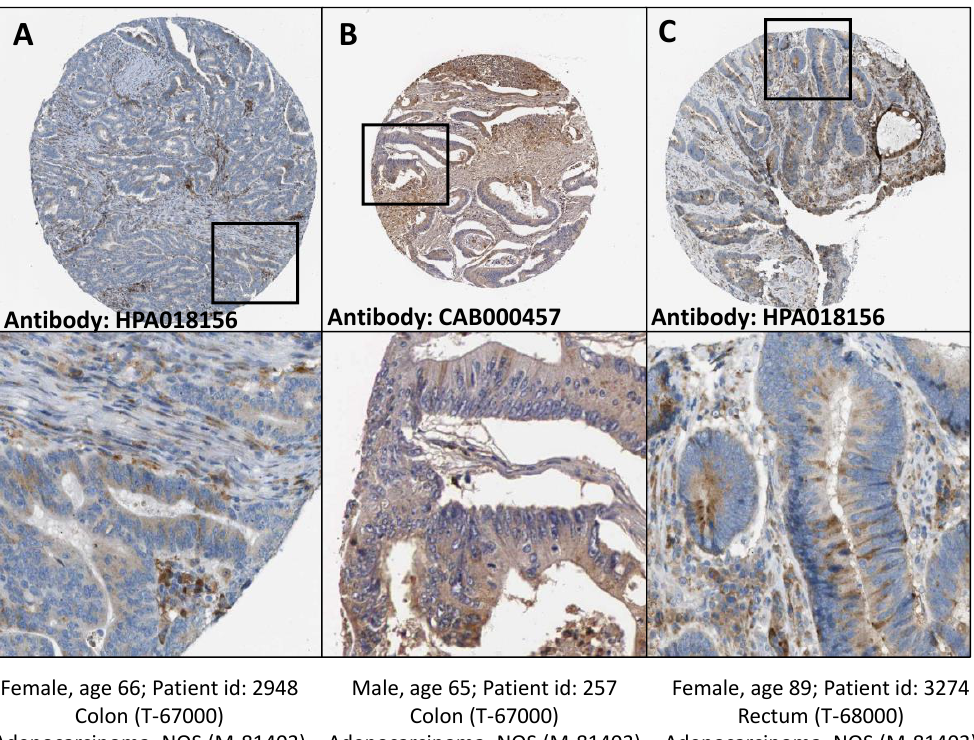
Figure 6. Cathepsin B detection in tissue samples from human colon and rectum adenocarcinoma. Human colon ( A , B ) and rectum ( C ) adenocarcinoma tissue samples, stained with anti cathepsin B antibodies HPA018156 ( A , C ) or CAB000457 ( B ). Cathepsin B location: cytoplasmic/membranous. Staining quality medium, staining intensity moderate. Image credits: Human Protein Atlas, www.proteinatlas.org, [36,38]. Image available at the following URL: ( A ) v18.proteinatlas.org/images/18156/41693_A_2_6.jpg;